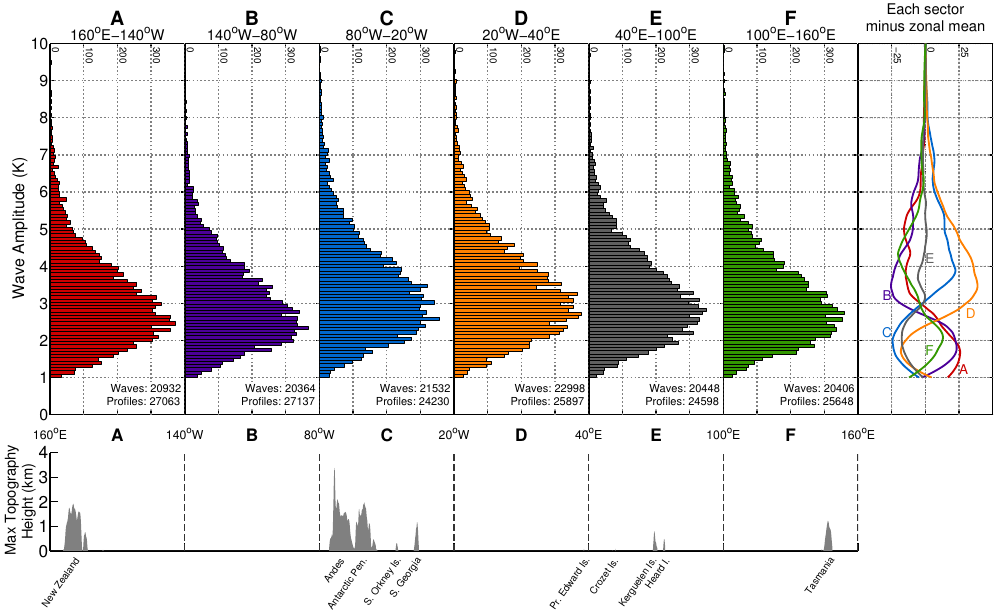
Figure 9. Histograms of individual wave amplitudes detected during June–August 2006–2012 in longitudinal sectors A–F in the latitude band 40–65 ◦ S using the Wave-ID method (see text). The rightmost panel shows the difference between the wave amplitude distribution in each sector and the zonal-mean distribution. The bottom panel shows maximum topography height in the latitude band 40–65 ◦